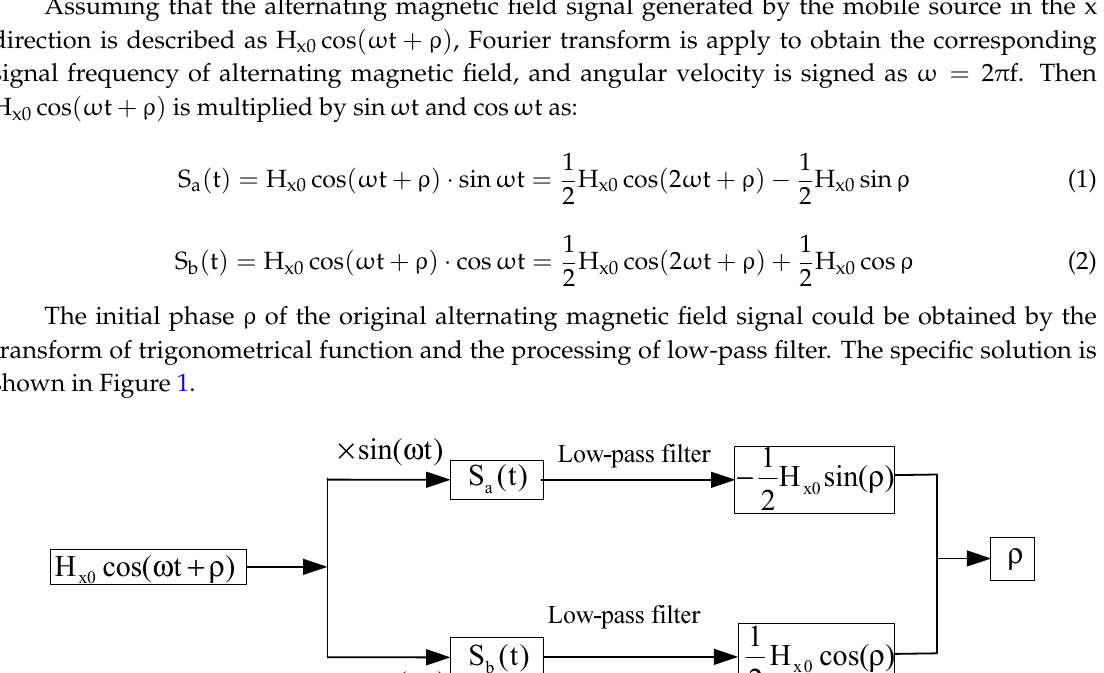
Figure 1. Specific solution to calculated initial phase